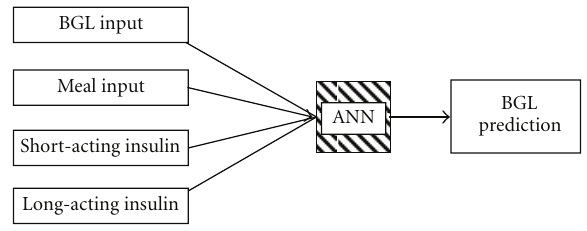
Figure 1: Schematic of inputs for short-term prediction ANN